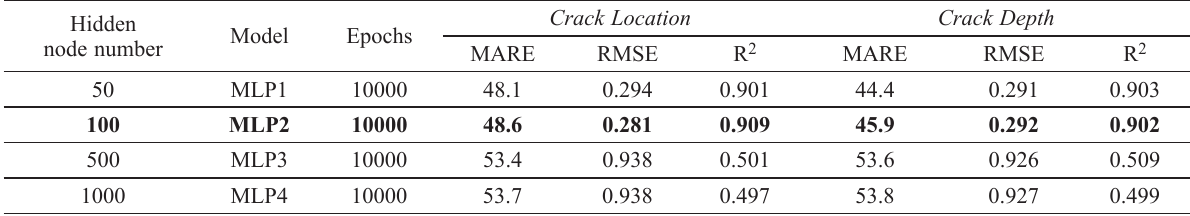
Table 4. The test results of the MLP models in estimation of crack parameters Hidden node